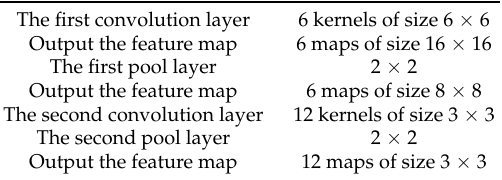
Table 4. Architecture of Deep Neural Network.